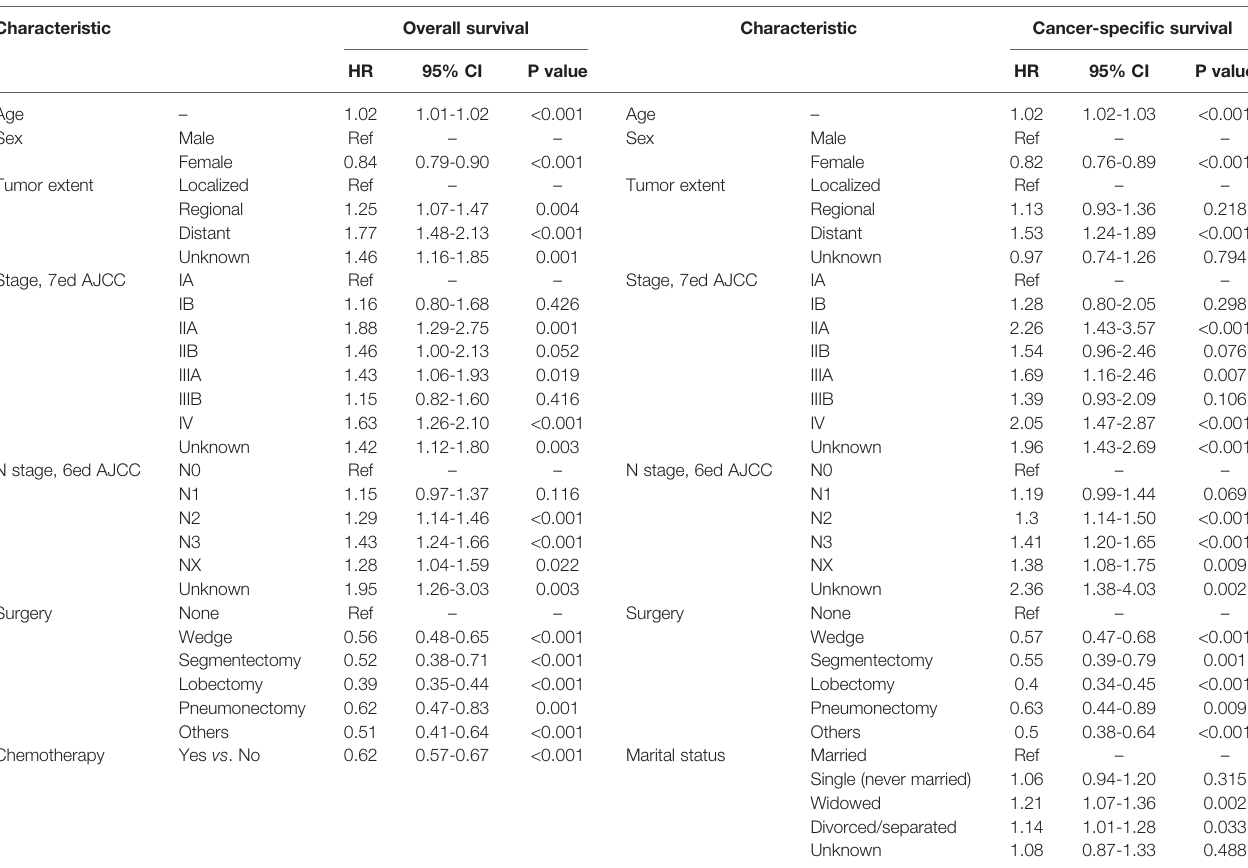
TABLE 4 | Multivariate Cox regression analyses for overall survival and cancer-speci fi c survival in patients with pulmonary large cell neuroendocrine carcinoma using SEER 18 Regs Custom Data (with additional treatment fi elds; November 2018 Submitted).